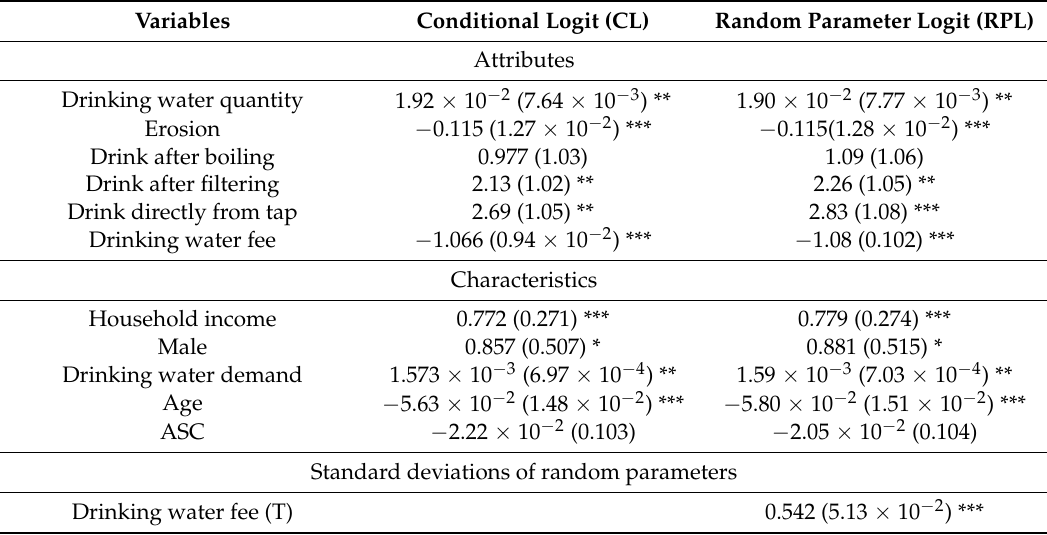
Table 3. Results of regression models (downstream /Dharan